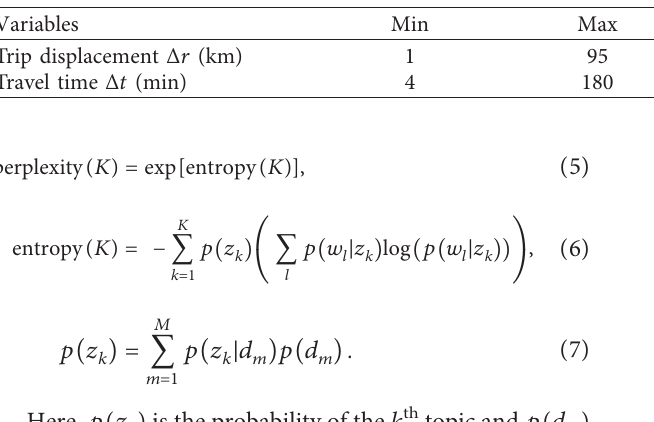
Table 3: Categorization of continuous variables.